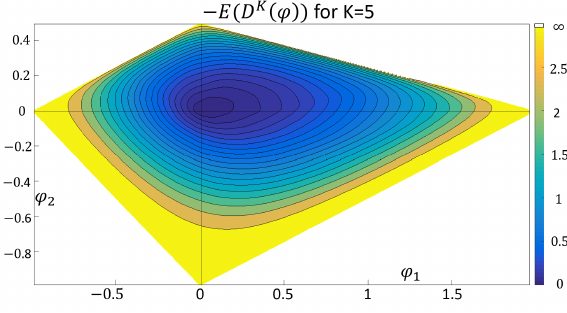
Figure 1. Contour levels for r ( K )